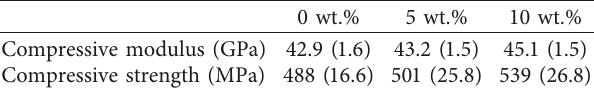
Figure 5: The schematic diagram of compressive modulus test: (a) two-phase composite and (b) three-phase Table 2: Summary of compression experimental results.